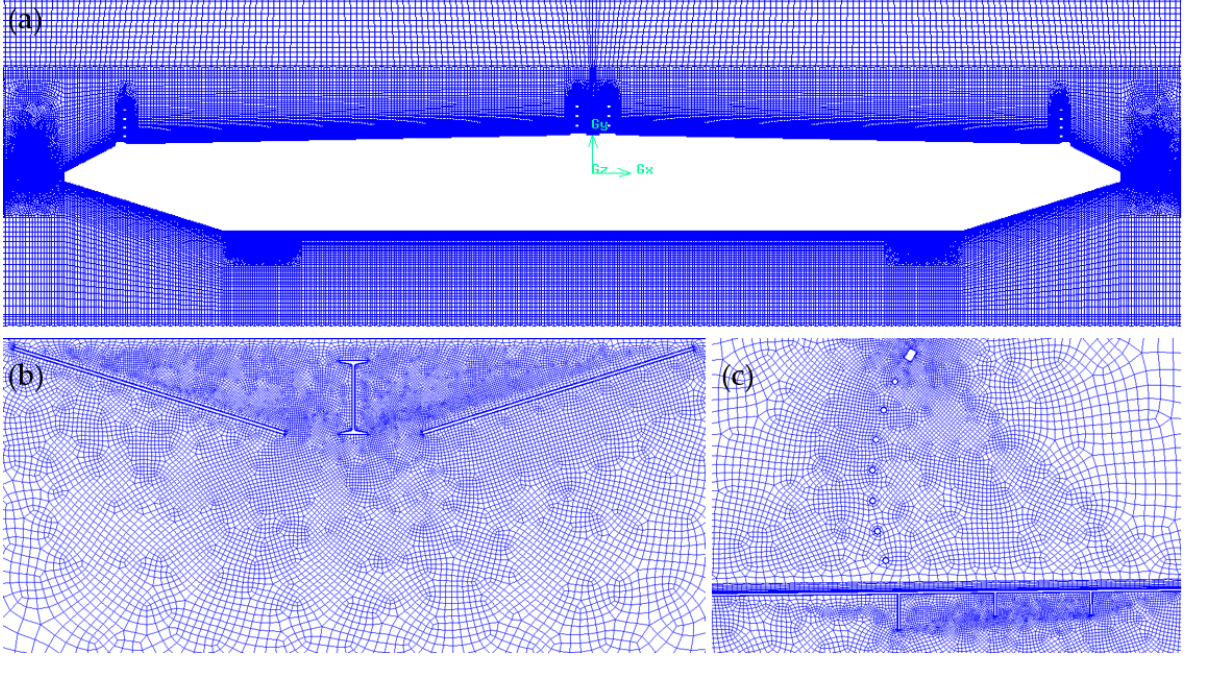
Figure 12. Local mesh division of the computational domain ( a ) near the main deck section; ( b ) near the maintenance vehicle tracks; and ( c ) near the sidewalk outriggers.